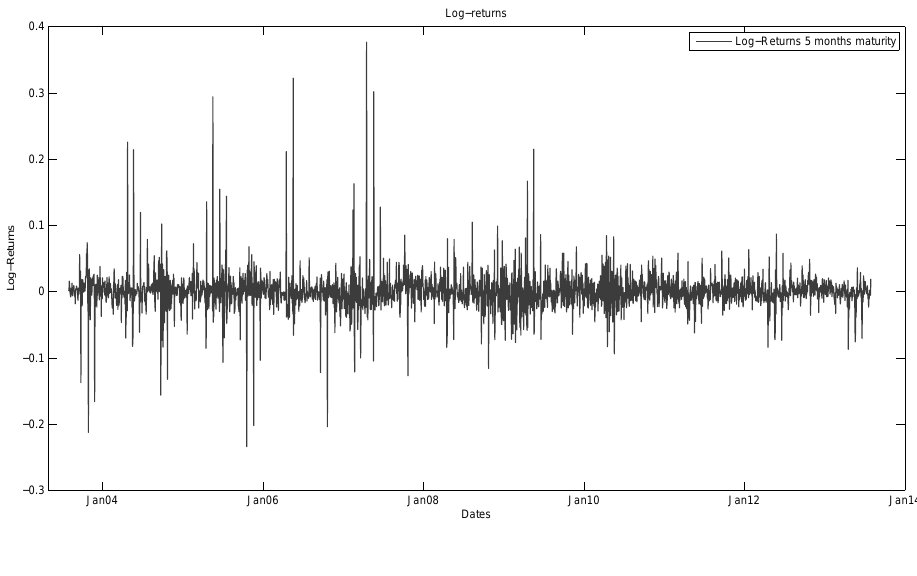
Figure 4. ICE U.K. Natural Gas deseasonalized